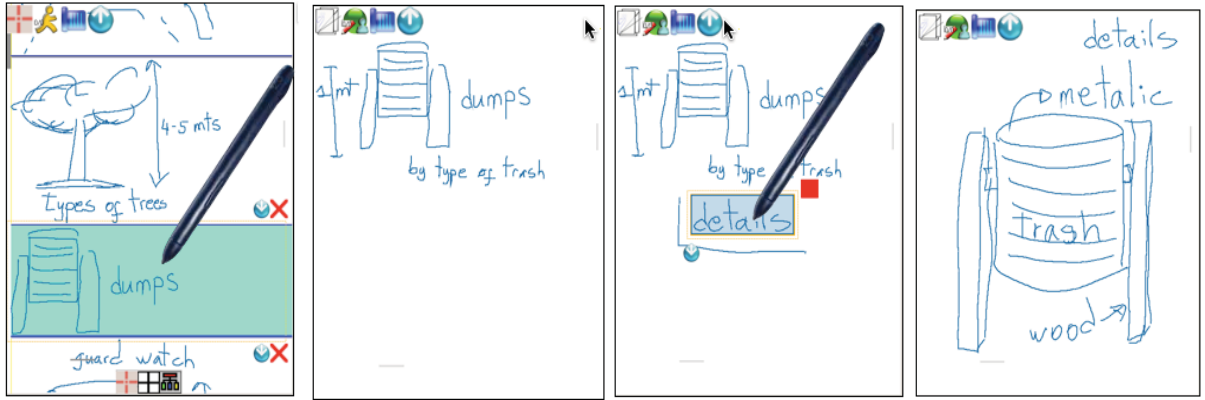
Figure 6. Editing ideas through sketching and freehand writing in the brainstorming/ brainsketching mode. From left to right: in the first screenshot an idea consisting of the design of a dump is generated with a brief explanatory text, this idea is separated from the rest by making a gesture corresponding to a horizontal line. To edit this idea, it is necessary to select it with a click of the pen and enter clicking the icon with the arrow down. In the second screenshot the idea previously selected is being re-edited by adding more details. The third shows how to generate a node through a gesture in the shape of a rectangle. This node is now a new sub-idea within an idea, which can also be edited by selecting and clicking on the icon with the arrow down, as shown in the last screenshot of the sequence, where details of the trashcan